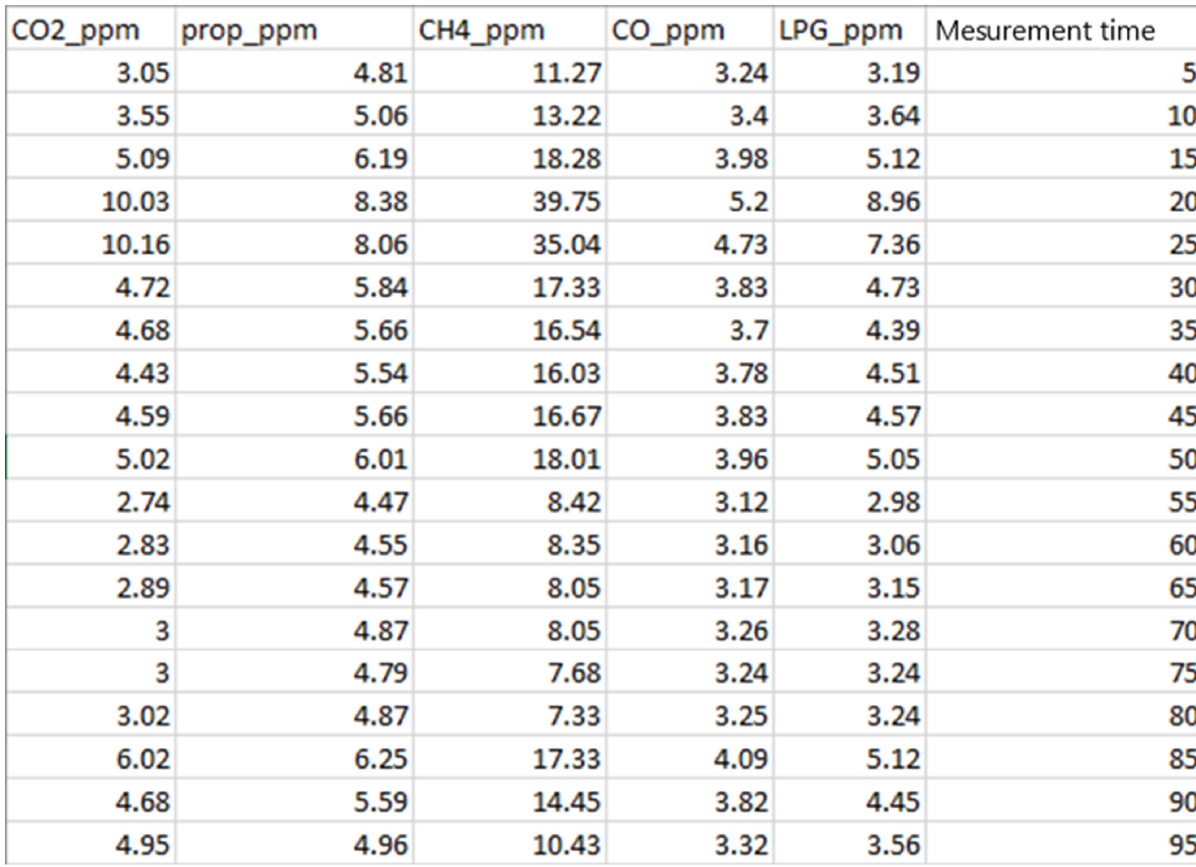
Figure 5. An example of a writing data file.